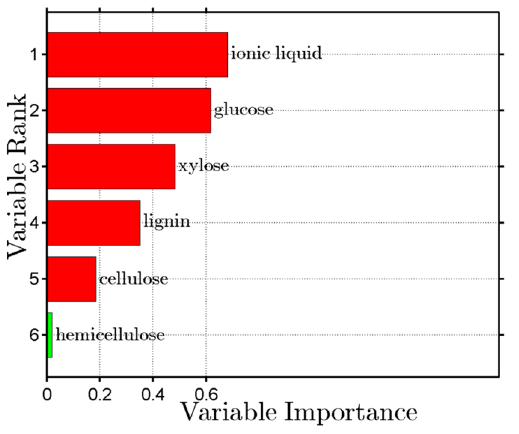
Figure 6. Relative importance of input features for estimating the ethanol